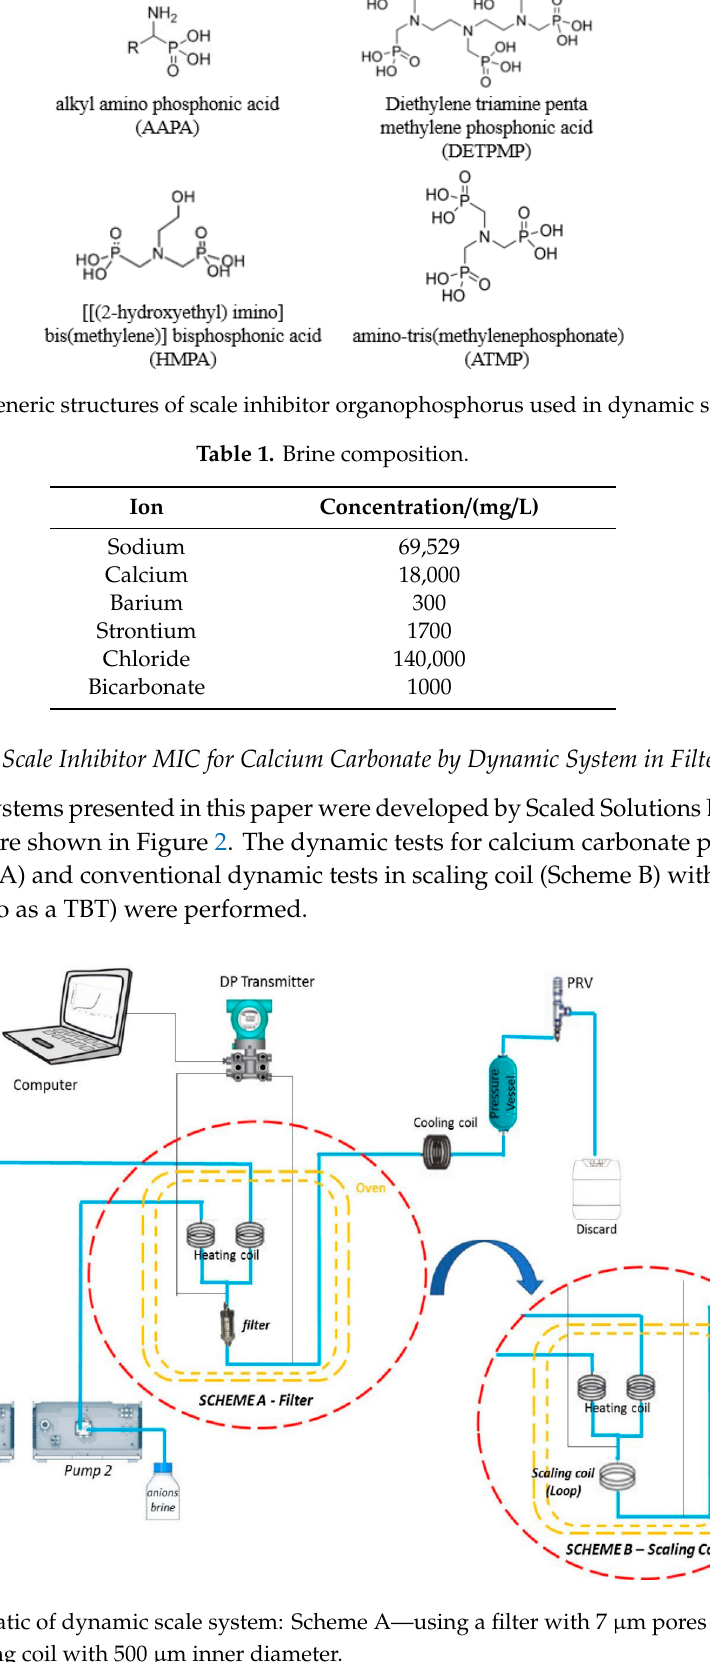
Figure 1. Generic structures of scale inhibitor organophosphorus used in dynamic systems.